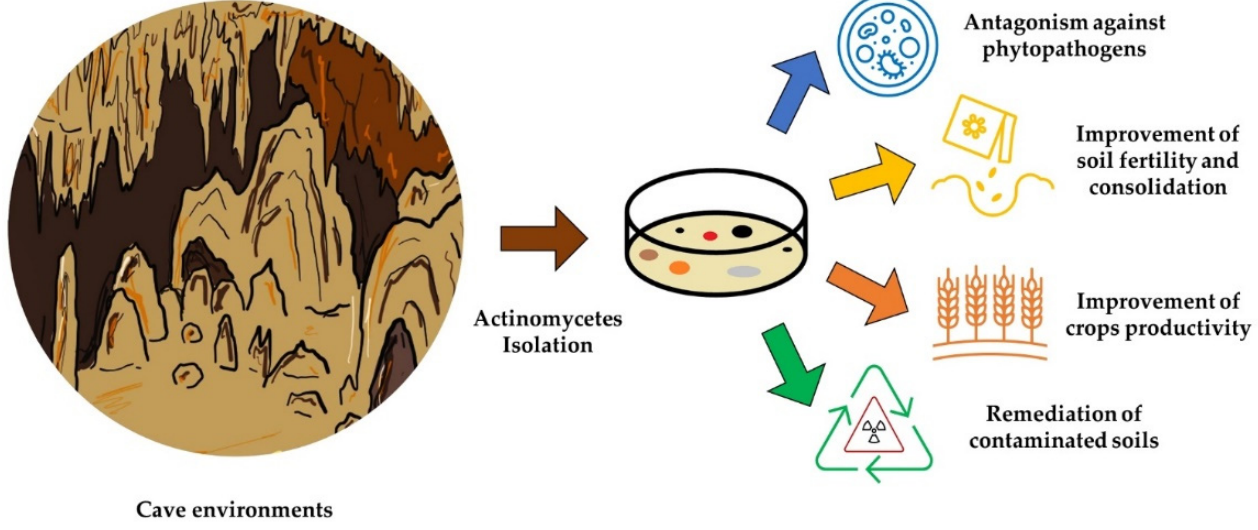
Figure 2. Schematic summary of the possible uses of actinomycetes isolated from cave environ- ments.